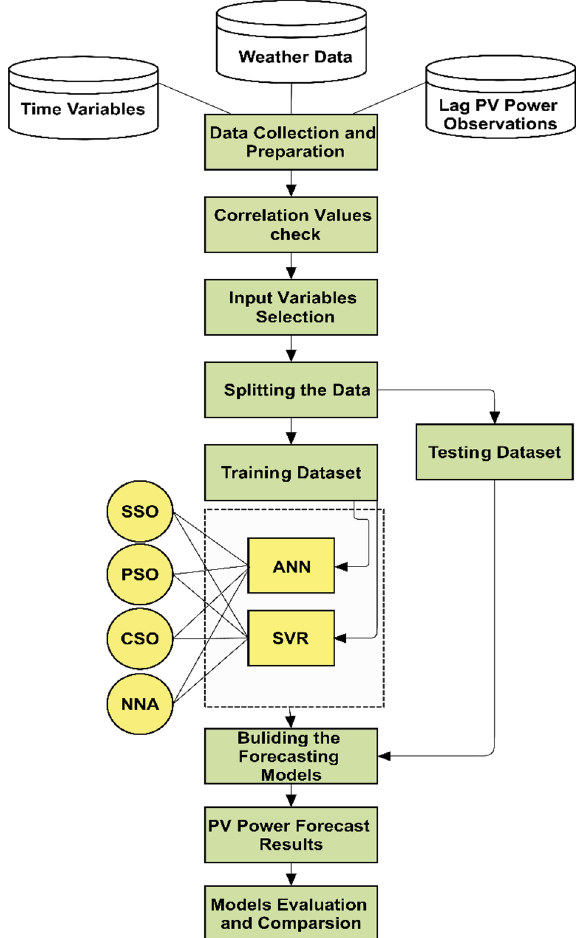
Fig. 1 Study framework for the proposed PV power forecasting